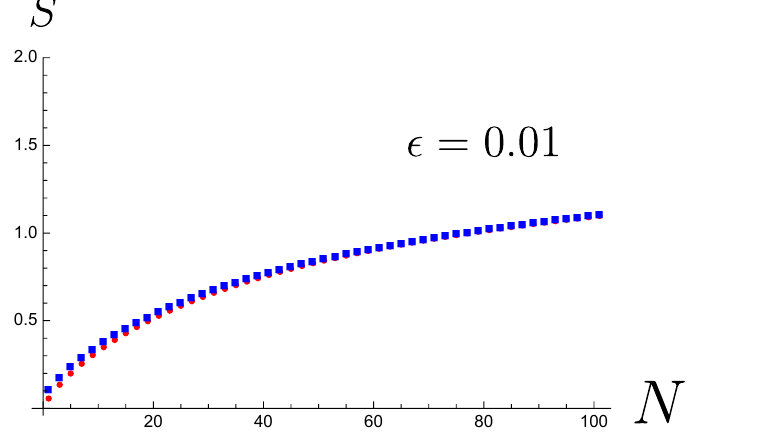
Figure 3 . Entanglement entropy for an interval. The subregion is an interval A = ( − (cid:15)L/ 2 , (cid:15)L/ 2) with (cid:15) = 0 . 01 . The blue square markers are the entanglement entropy for the Dirichlet boundary condition. The red round markers are for the periodic